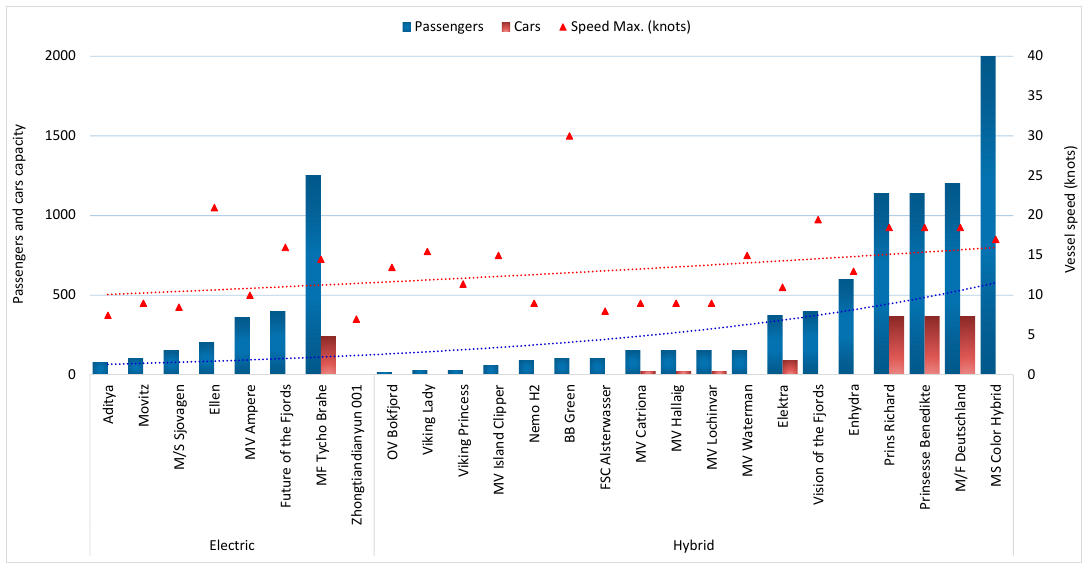
Figure 7. Electric and hybrid vessels (Passenger/car capacity and vessel speed)). Energies 2020 , 13 , x FOR PEER REVIEW